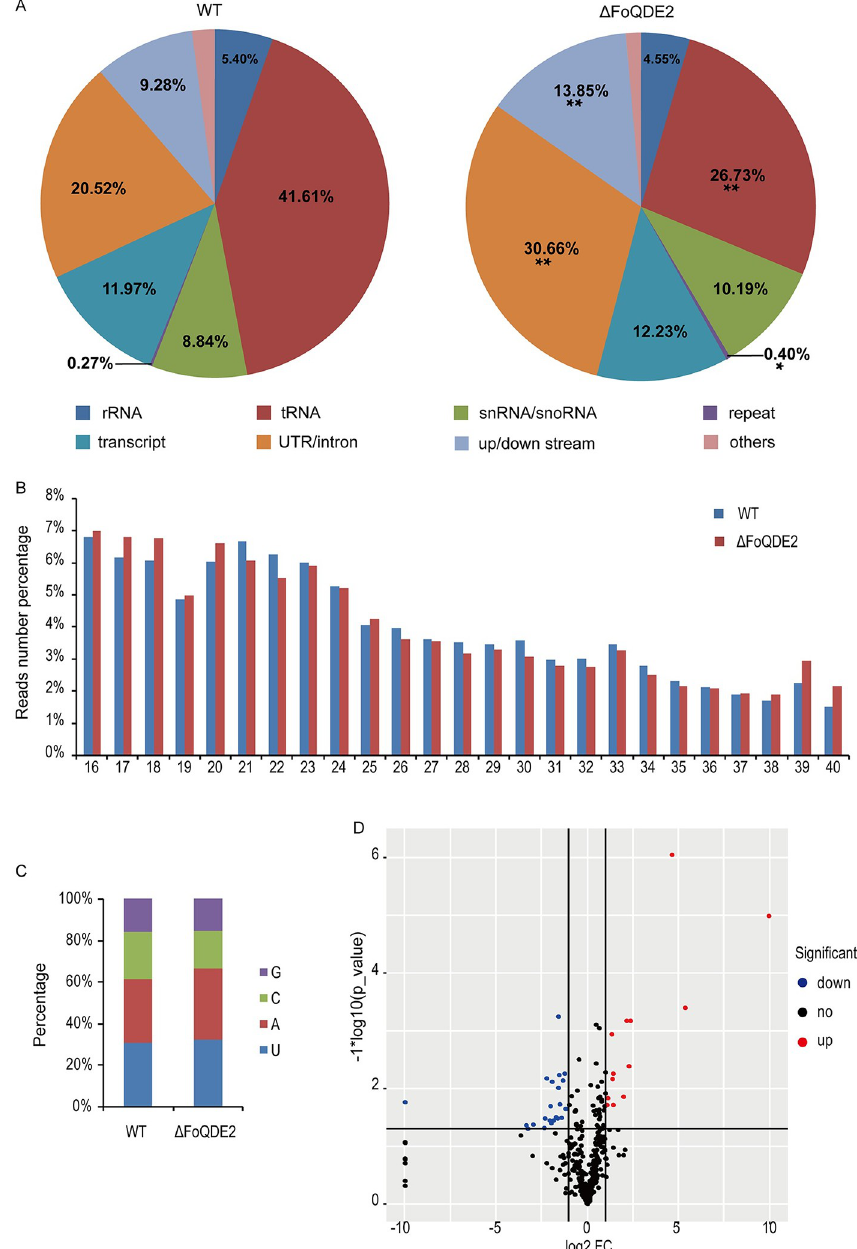
Fig 4. Small RNA sequencing analysis in F . oxysporum f. sp. cubense . ( A ) Characterization of small RNA-producing loci. ( B ) Length distribution of small RNAs. ( C ) Analysis of the 5 0 end nucleotide preference of small RNAs. ( D ) Differential analysis of small RNA expression in the WT and Δ FoQDE2